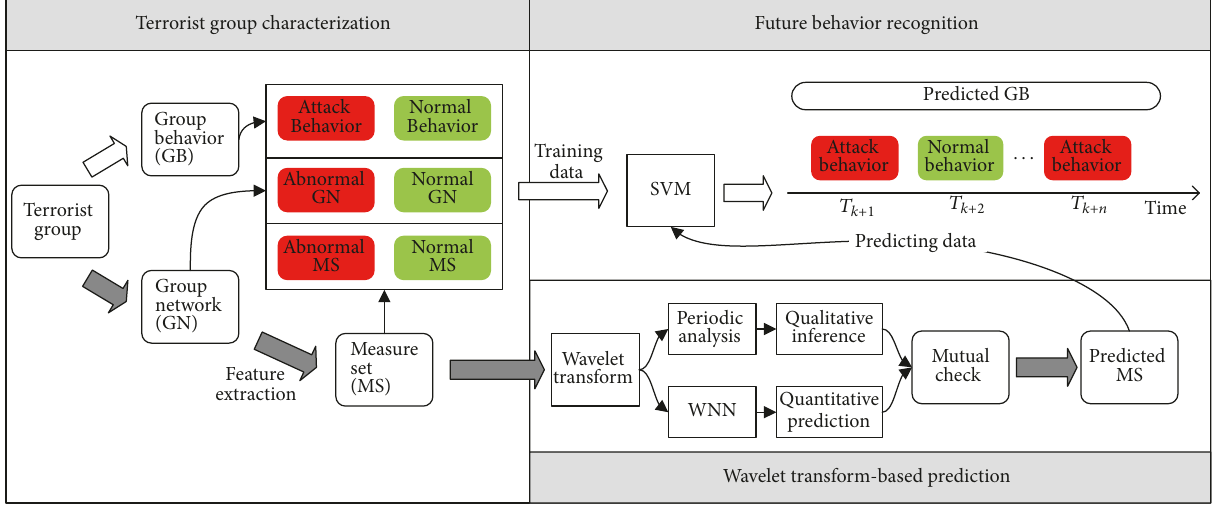
Figure 2: Framework of predicting attack behavior of a terrorist group through the group